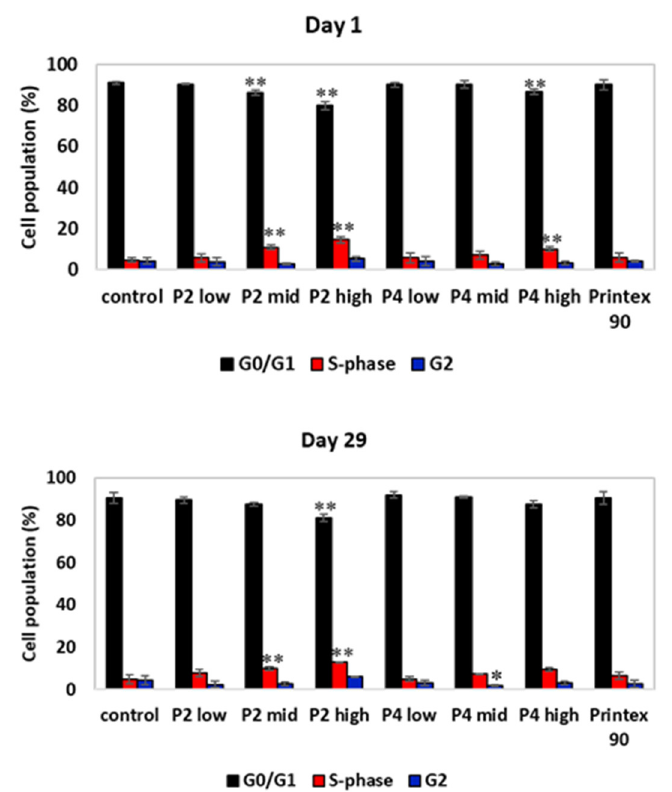
Figure 9. Cell cycle analysis of BAL cells on day 1 and day 29 post-exposure of the 28-day nose-only inhalation study. The distribution of cells in each of the cell cycle phases was based on cell DNA content by staining with propidium iodide. The percentage of cells at each of the cell cycle phases was determined using the FlowJo software. */** Statistically significant difference from control at p ≤ 0.05, p ≤ 0.001, respectively; Dunnett’s test.